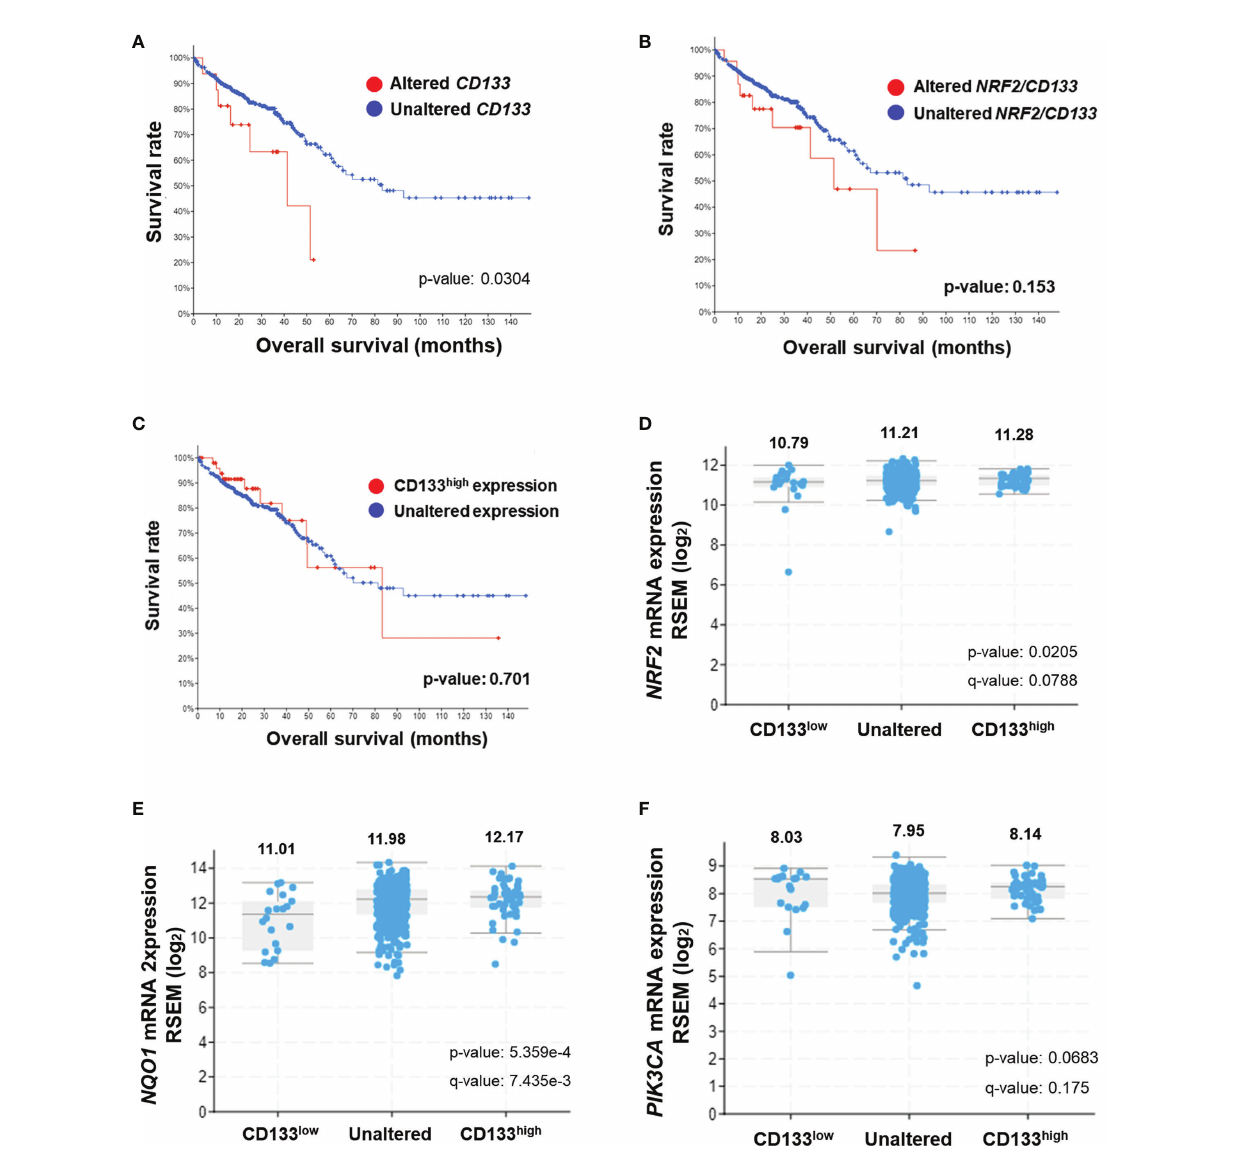
FIGURE 6 | Association of CD133 with NRF2 and clinical outcome of colorectal cancer patients. (A) Overall survival rates of colorectal patients with altered (n = 17) vs unaltered (n = 509) CD133 gene. (B) Overall survival rates of colorectal patients with altered (n = 24) vs unaltered (n = 502) NRF2 or CD133 gene. (C) Overall survival rates of colorectal patients with high CD133 (n = 52) vs unaltered (474) mRNA levels. Plots generated by cBioPortal were modi fi ed. (D – F) Correlation of CD133 mRNA levels (high CD133, n = 52; unaltered CD133, n = 454; low CD133, n = 20) with NRF2 (D) , NQO1 (E) , and PIK3CA (F) mRNA levels in colorectal tumors. Values are given in (RNA Seq V2 RSEM) in log2. Plots generated by cBioPortal were modi fi